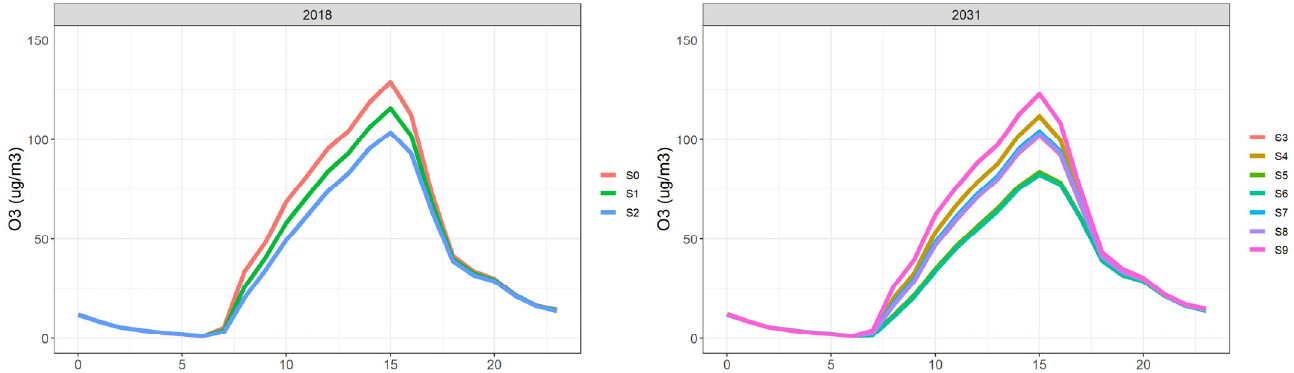
Figure 6. O 3 ( µ g/m 3 ) concentrations for scenarios in 2018 and 2031. Note that the meteorology of 2018 was used and the scenarios in 2031 are based on the emissions projected for the year 2031.